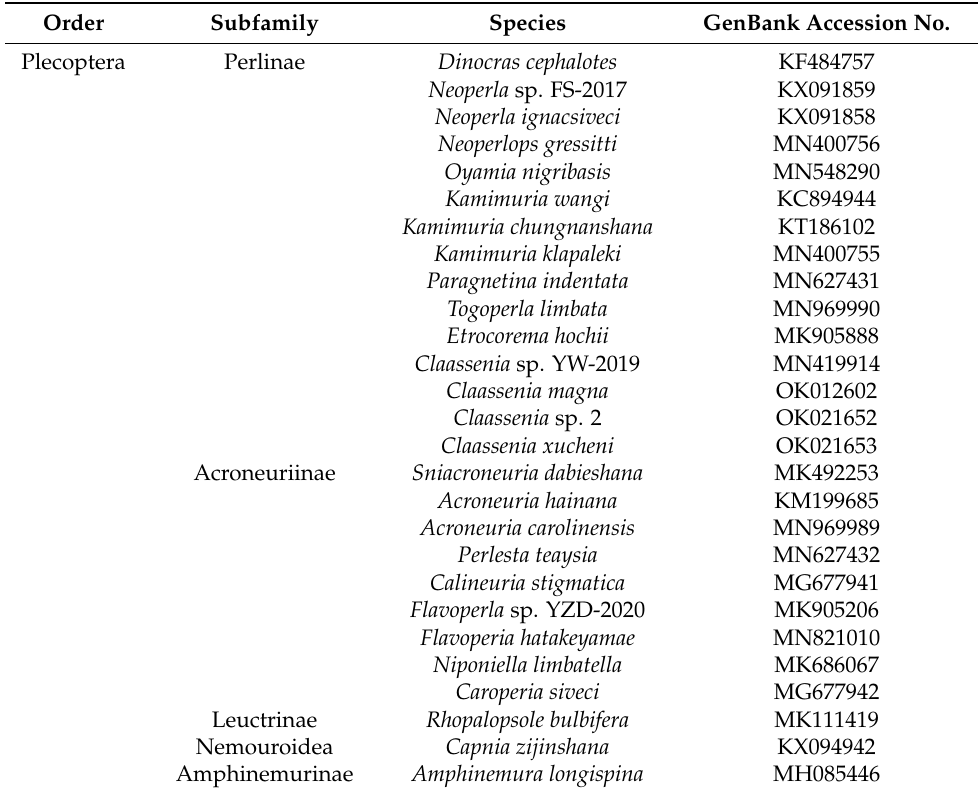
Table 1. List of species analyzed in this